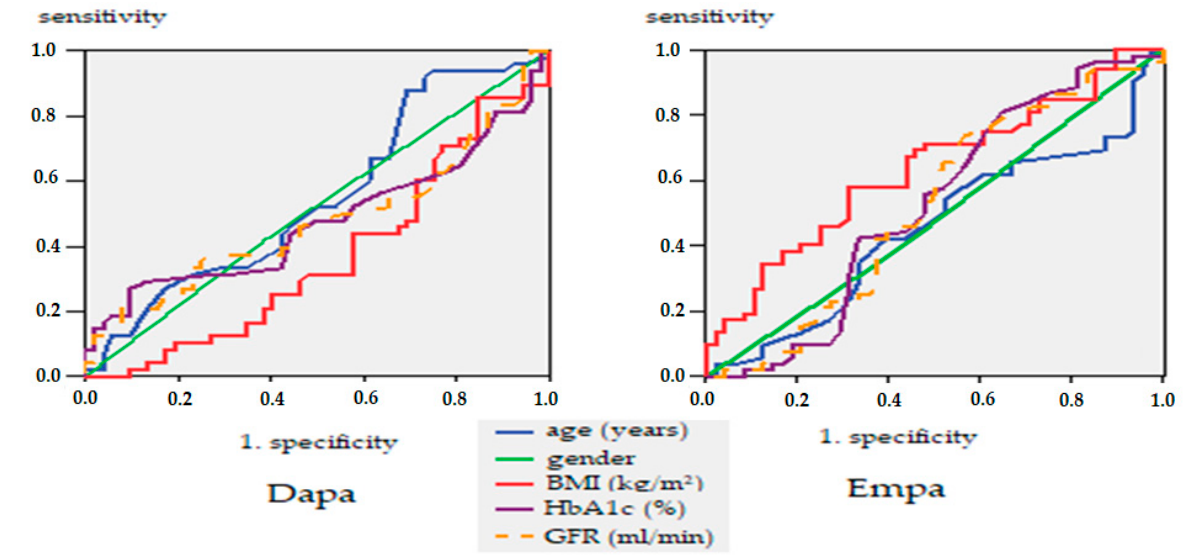
Figure 9. ROC curve. Prognostic factors in the selection of SGLT-2 treatment.